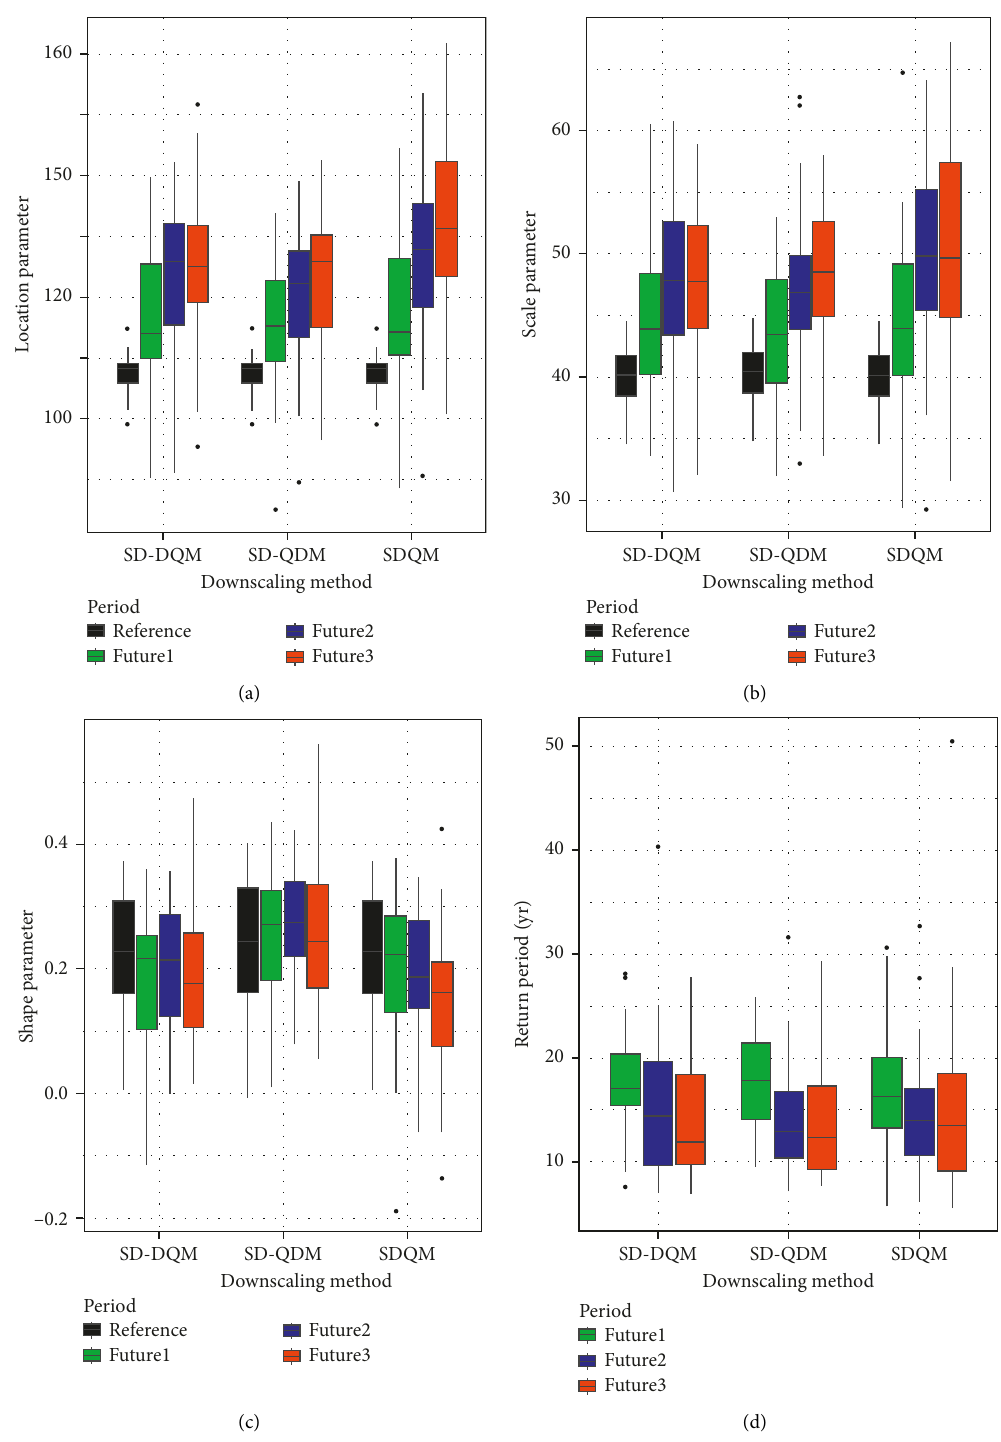
Figure 5: Box-plot of (a) location, (b) scale, (c) shape parameter of GEV distribution for CMIP5 precipitation, and (d) return period of future for 20-year precipitation of reference